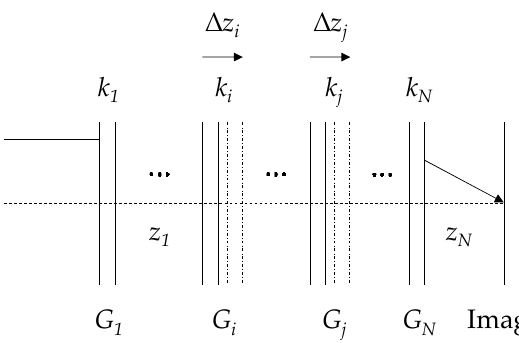
Figure 3. Optical layout with i-th and j-th group movement.